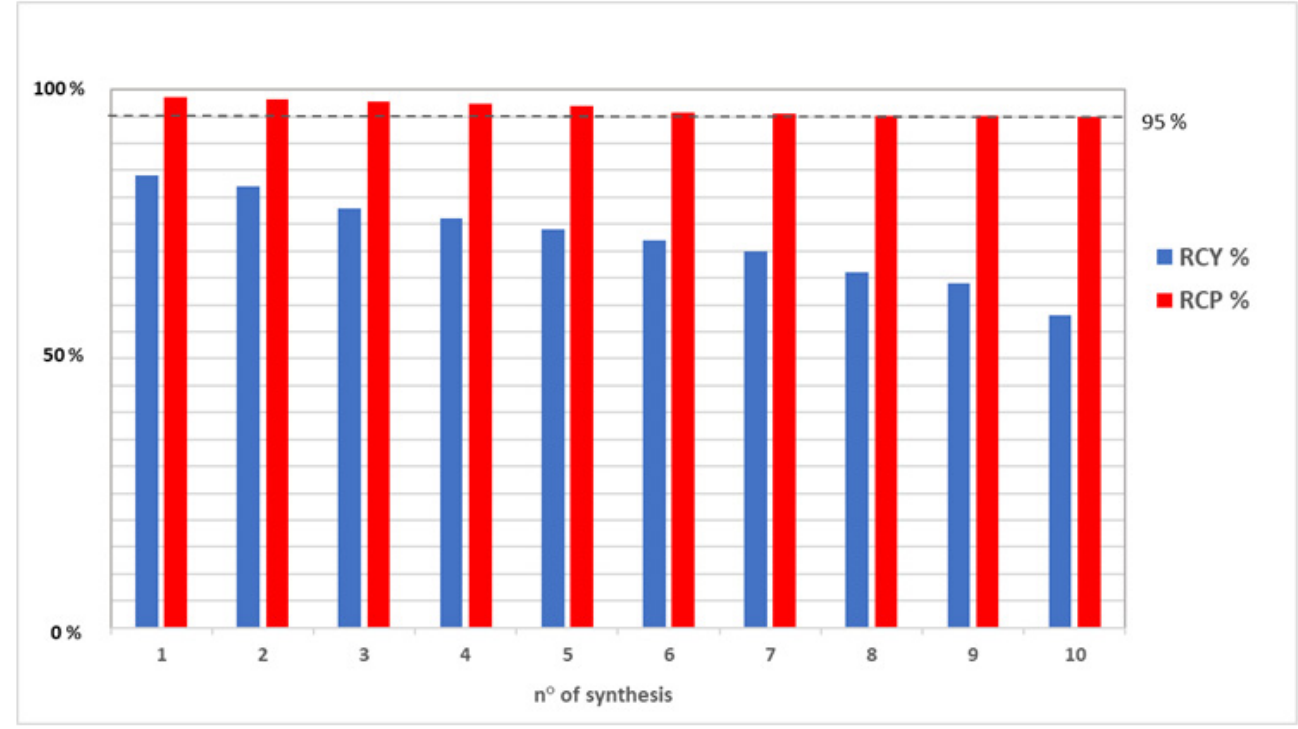
Figure 3. Comparison between % RCY (blue bars) and % RCP (red bars) data from [ 68 Ga]Ga-PSMA-11 preparations: a decrease of % RCY corresponds to a decrease in % RCP close to the lower limit of the pharmacopeia specifications. The dotted line represents this minimum acceptable value of % RPC (95%).